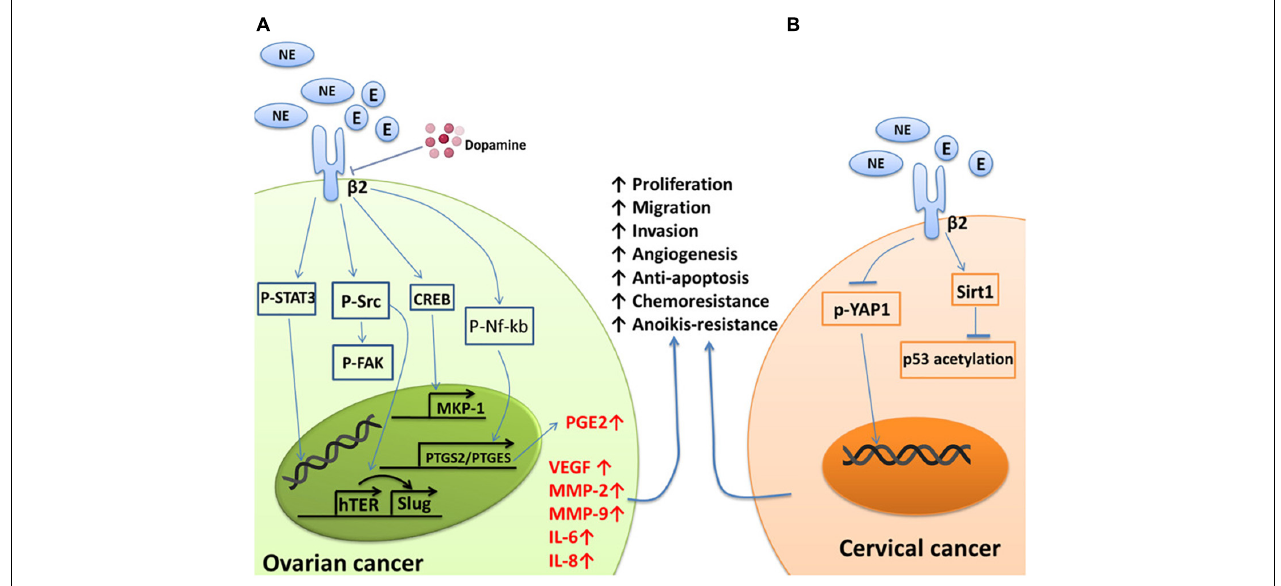
FIGURE 1 | Summary of the effects of NE/E on pathways involved in cancer cell survival, metastasis, and chemoresistant signaling. (A) NE binds to ADRB2 to activate Src, which then induces the phosphorylation of FAK and the expression of VEGF, IL-6, and IL-8, conferring anoikis resistance, metastasis, and angiogenesis in ovarian cancer cells. STAT3 is phosphorylated and translocates to the nucleus to transactivate the target genes MMP-2 and MMP-9. NE can also activate ADRB2 to transcriptionally activate PTGS2 and PTGES via Nf-kb to produce PGE2. Finally, NE can induce ovarian cancer cells to become resistant to chemotherapy by acting on a target gene to induce MKP-1 expression through CREB. Additionally, NE-mediated tumor growth and angiogenesiscan be blocked by dopamine. (B) YAP1 is dephosphorylated and translocates from the cytoplasm to the nucleus in response to NE signaling, which results in anoikis resistance, a process initiated by the activation of ADRB2. Norepinephrine can also activate ADRB2 to induce chemoresistance by suppressing the acetylation of p53 through the upregulation of Sirt1 in cervical cancer cells.